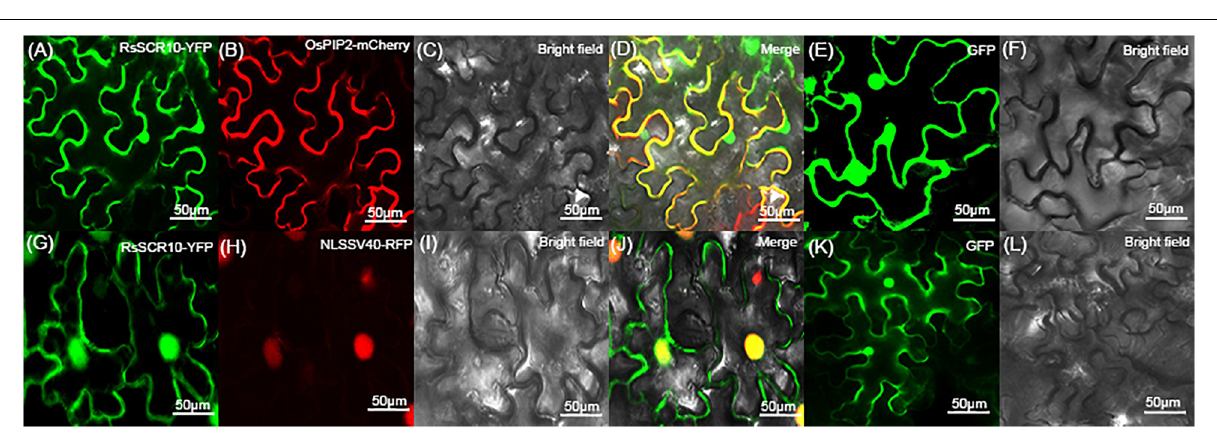
hybrid proline- or glycine-rich protein 8 ( OsHyPRP8 ) ([MSU locus ID: LOC_ Os04g46830], and similar to branched-chain- amino-acid aminotransferase 3 ( OsBcat-3 ) [MSU locus ID: LOC_Os03g12890]. Bimolecular fluorescence